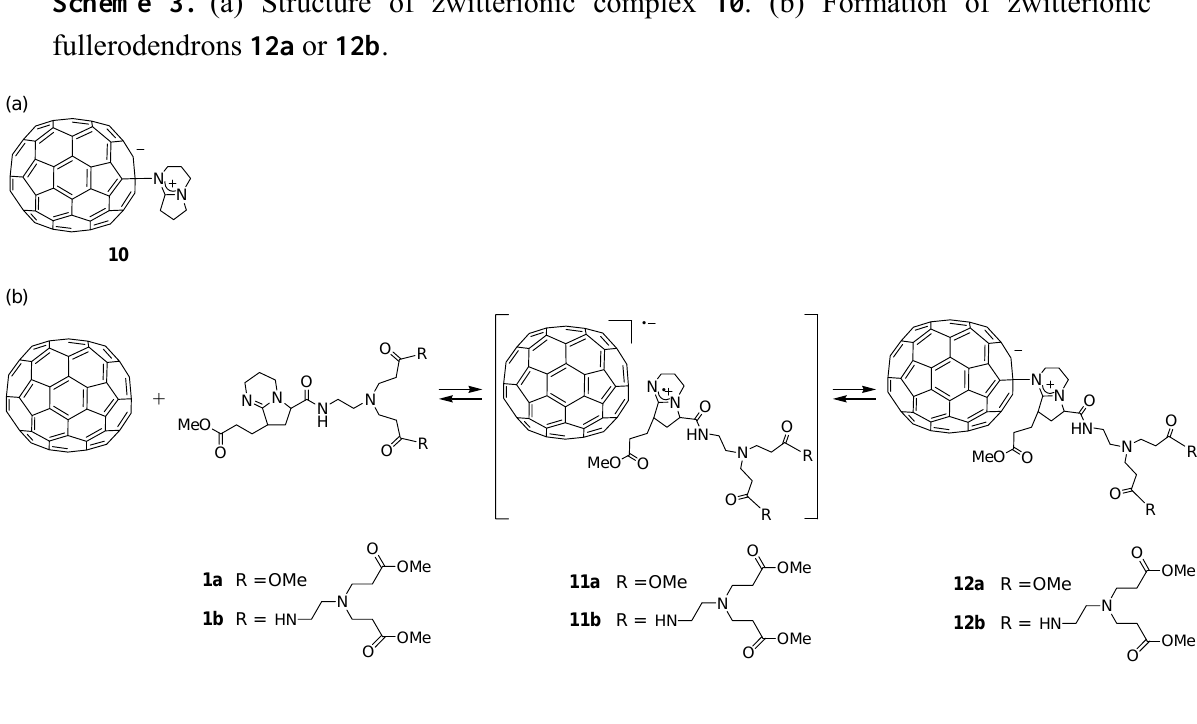
Figure 4. Vis-NIR spectra of the zwitterions 12b and radical ion pair 11b in benzonitrile. Inset: Expanded Vis-NIR spectrum of radical ion pair 11b